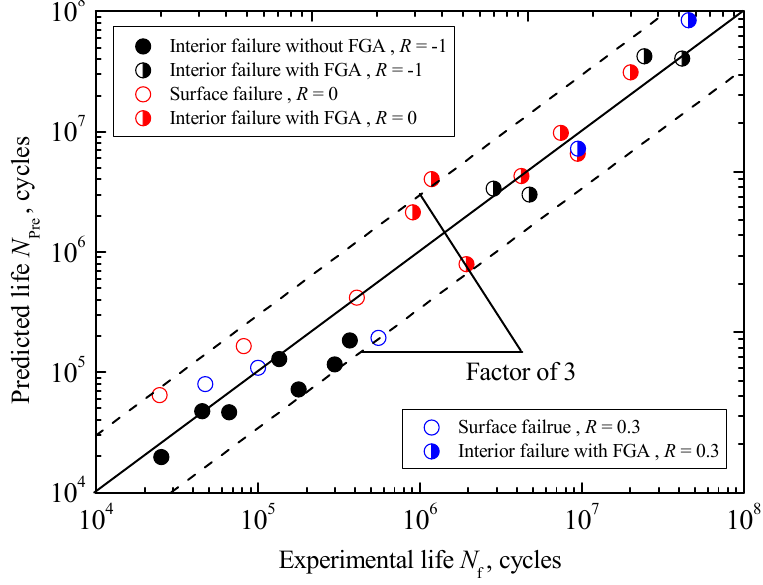
Figure 15. Predicted crack growth lives for surface failure.